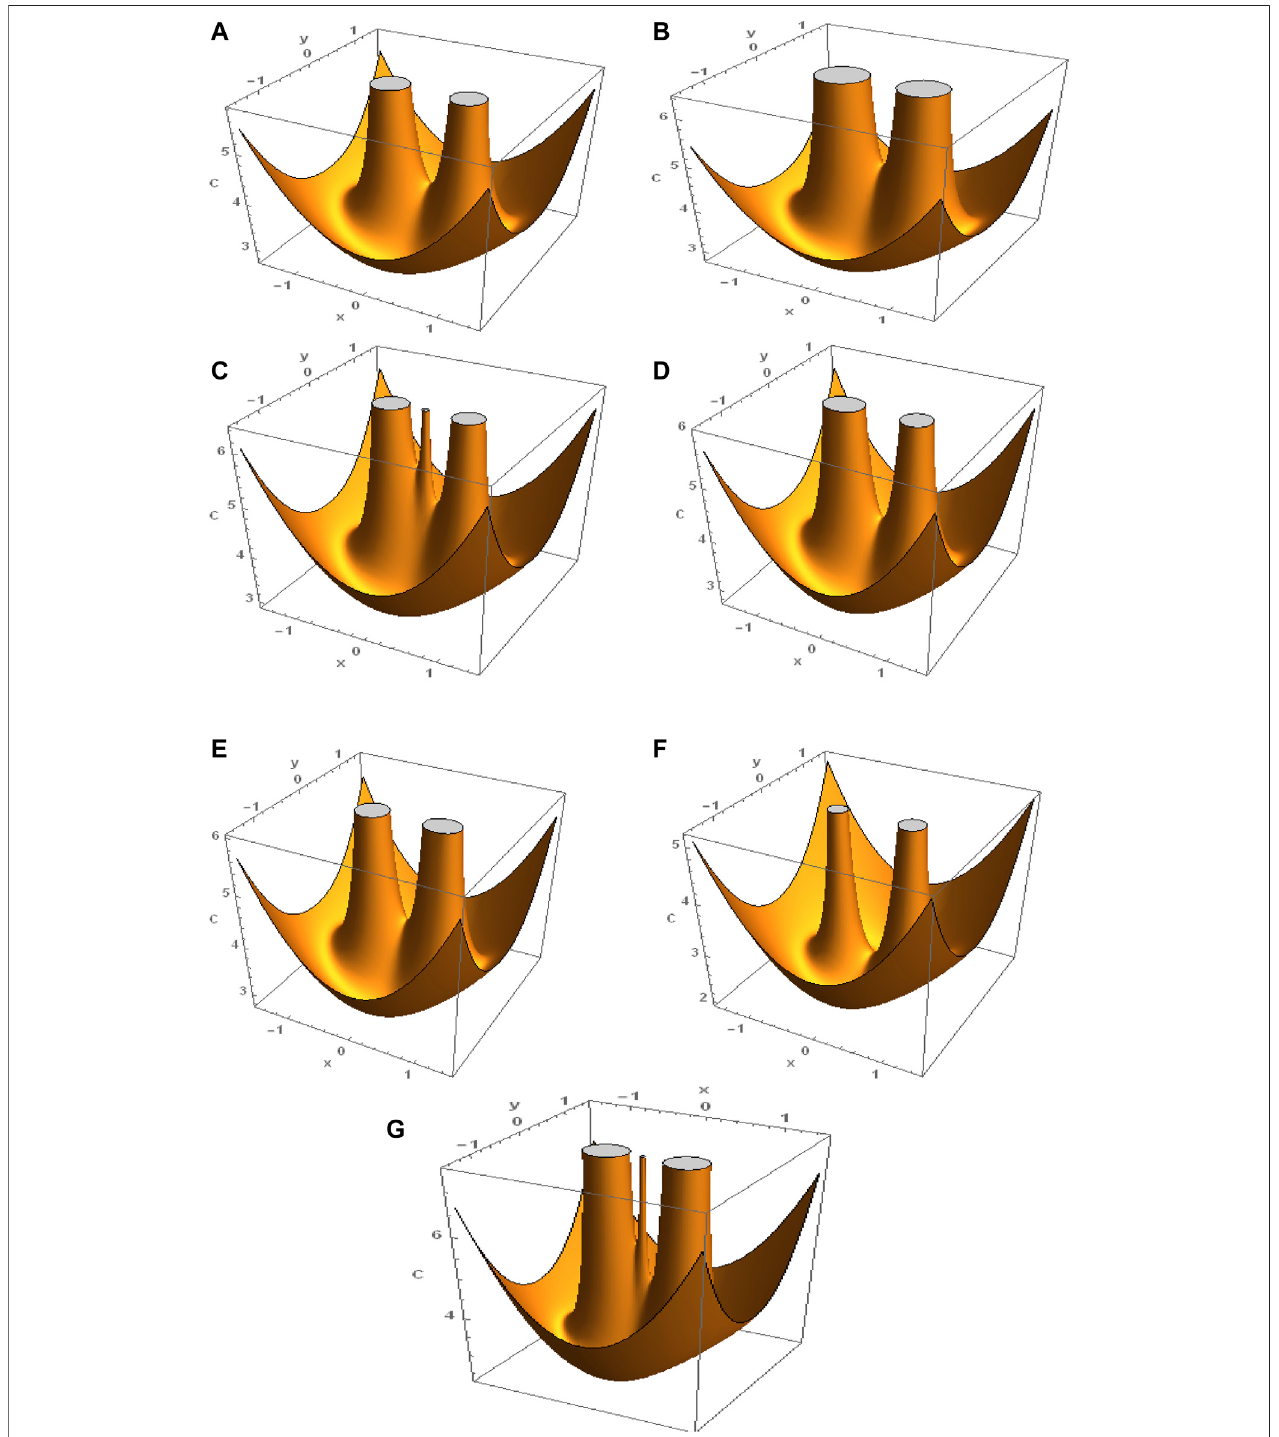
FIGURE 4 | (Color fi gure online) Zero-velocity surfaces of the HD155876 ( μ = 0.4583) binary system for (A) A 3 = 0, σ 1 = σ 2 = 0, σ 1 ′ (cid:1) σ 2 ′ (cid:1) 0, M b = 0, and q 1 = q 2 = 1 (classicalcase); (B) A 3 =0.09, σ 1 = σ 2 =0, σ 1 ′ (cid:1) σ 2 ′ (cid:1) 0, M b =0,and q 1 = q 2 =1case; (C) M b =0.05, T =0.01, A 3 =0, σ 1 = σ 2 =0, σ 1 ′ (cid:1) σ 2 ′ (cid:1) 0,and q 1 = q 2 =1case; (D) σ 1 = 0.02, σ 2 =0.01, σ 1 ′ (cid:1) σ 2 ′ (cid:1) 0, A 3 =0, M b =0,and q 1 = q 2 =1case; (E) σ 1 ′ (cid:1) 0 . 02, σ 2 ′ (cid:1) 0 . 01, σ 1 = σ 2 =0, A 3 =0, M b =0,and q 1 = q 2 =1case; (F) q 1 =0.5, q 2 =0.8, A 3 =0, σ 1 = σ 2 =0, σ 1 ′ (cid:1) σ 2 ′ (cid:1) 0,and M b =0case; (G) q 1 =0.45, q 2 =0.75, A 3 =0.1, σ 1 =0.07, σ 2 =0.05, σ 1 ′ (cid:1) 0 . 03, σ 2 ′ (cid:1) 0 . 02, M b =0.055,and T =0.01case.Thepresenceof thenewcollinearpointsisobviousinpanels (C) and (G) .Motionispermittedinsidethechimneysandbelowit.NotethedifferentscalesofJacobianconstant C inthe fi rst and the next